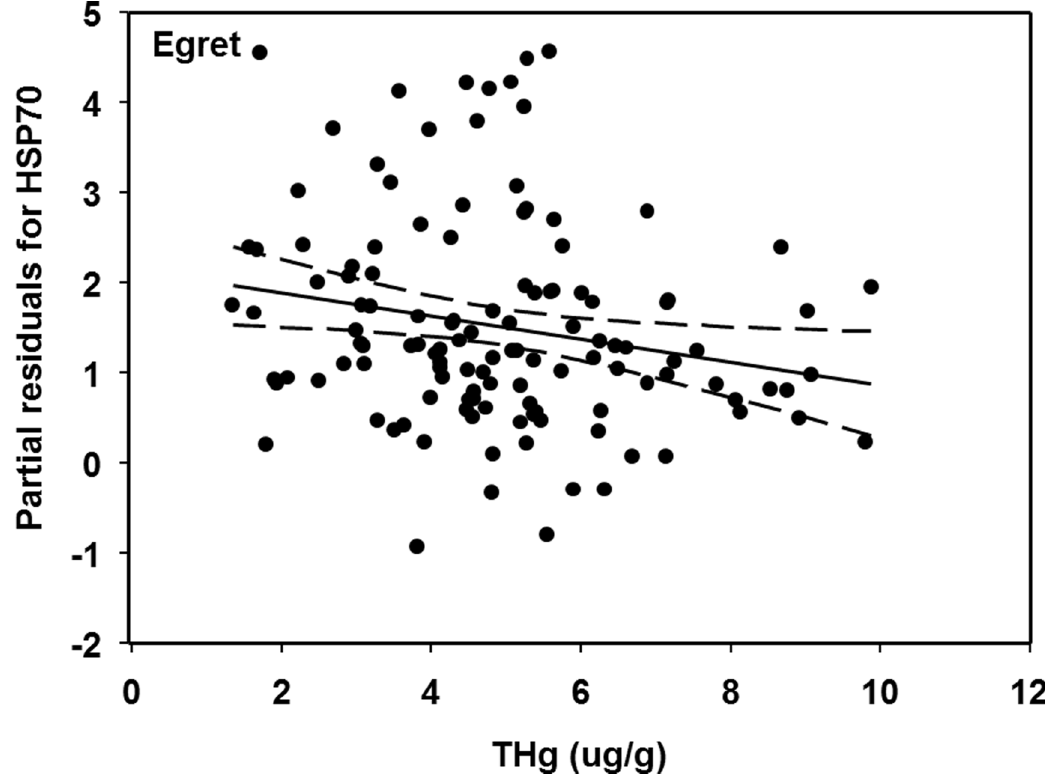
Figure 3. Partial residuals of HSP70 concentrations (ng/ml) and red blood cell THg ( m g/g dw) for great egret chicks in the Florida Everglades, after accounting for other model variables. Dashed lines indicated 95% confidence interval.